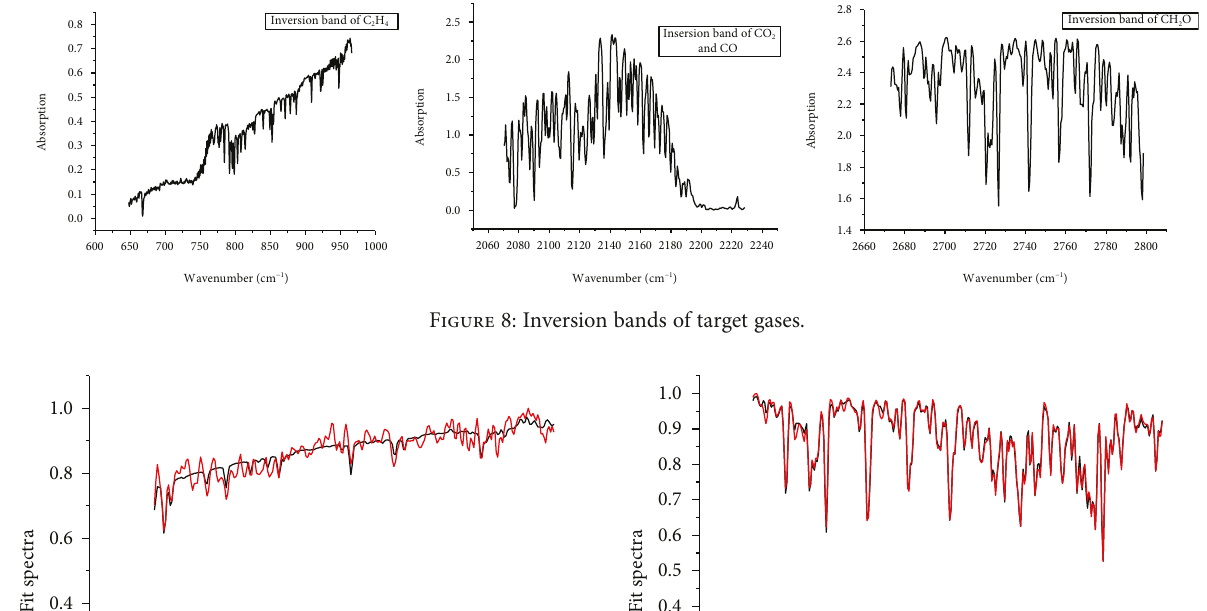
H , (b) the fi tting result of CH 2 4